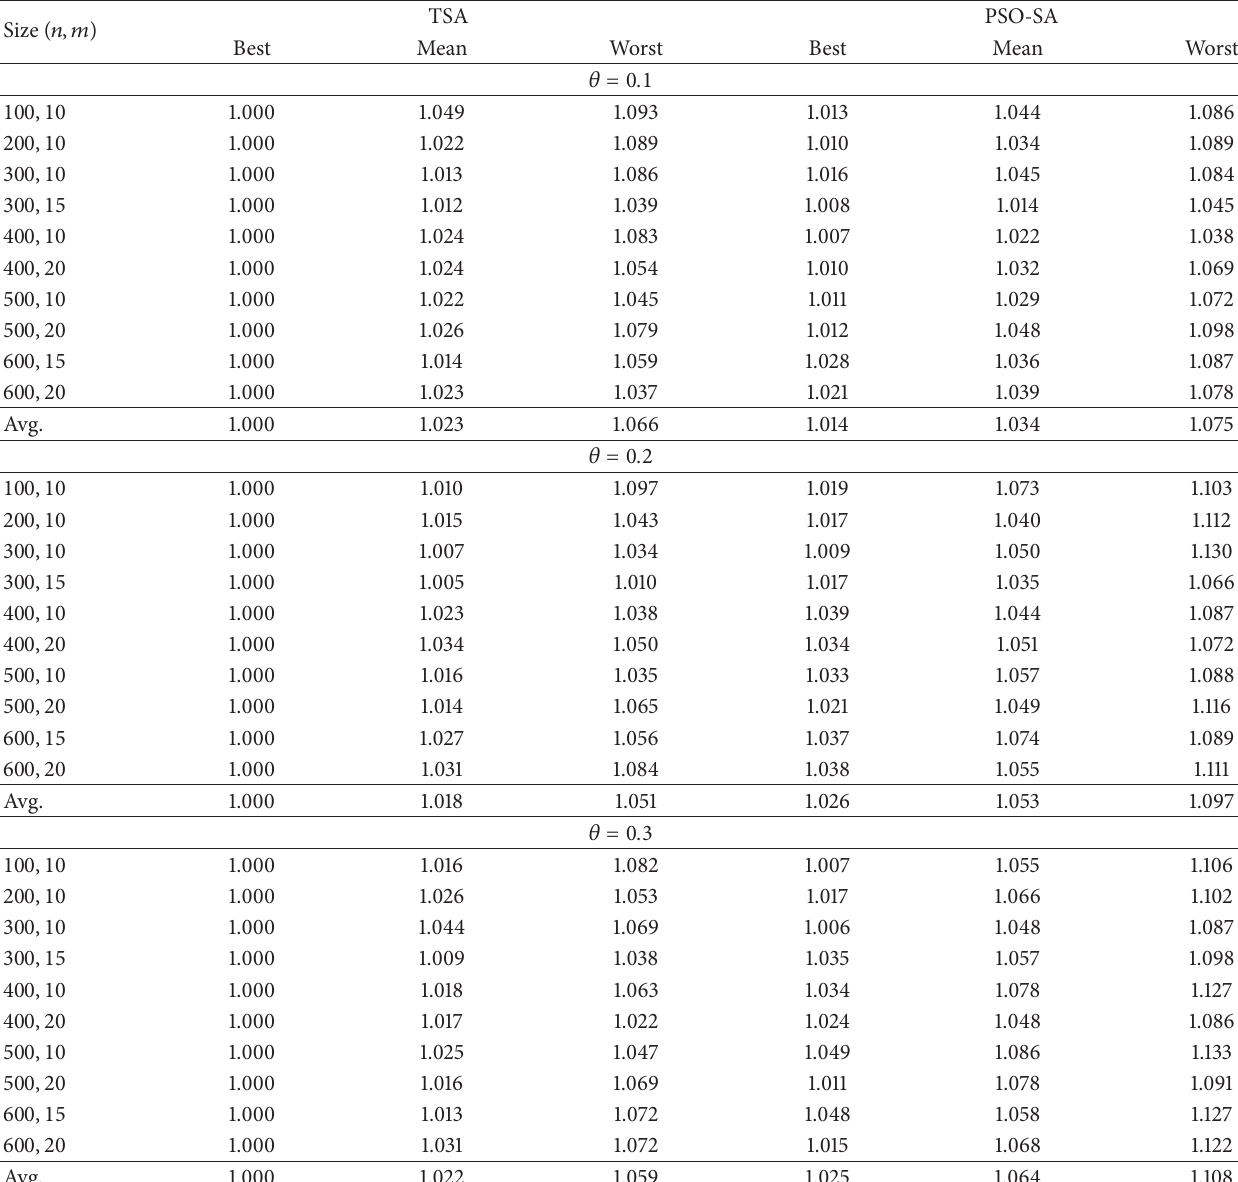
Table 2: The computational results under normal